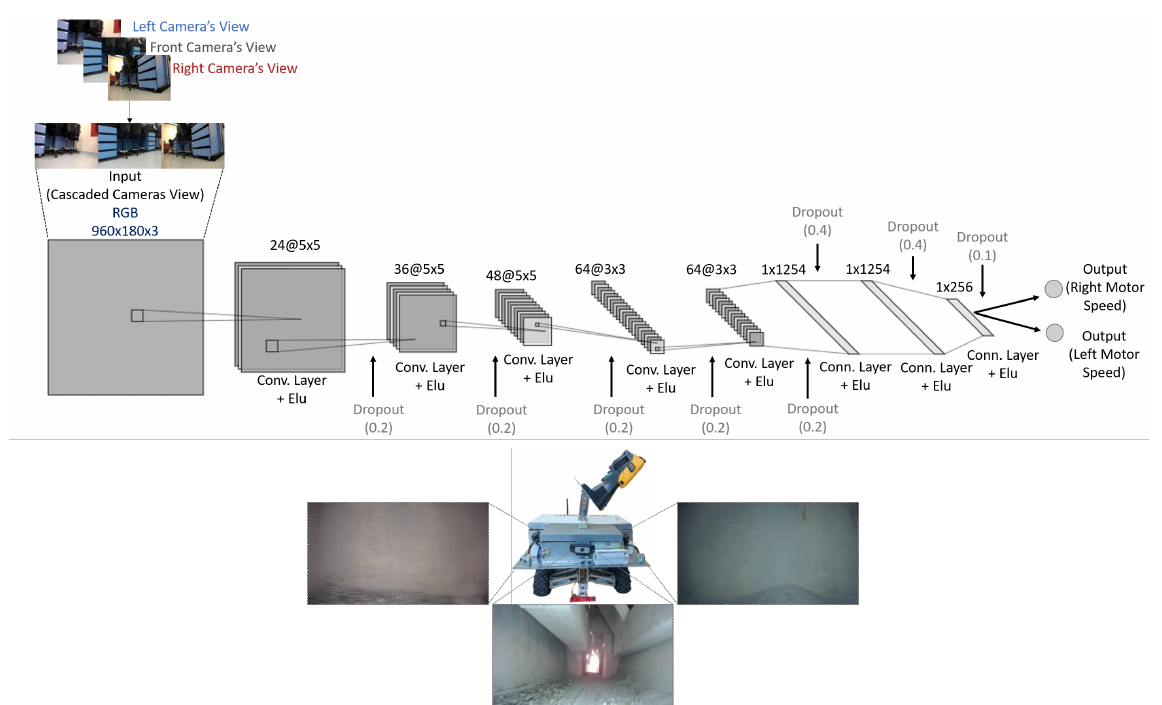
Figure 6. Top: Proposed self-driving deep architecture for real-time speed and steering angle control. Bottom: mounted wide-angle cameras and corresponding views